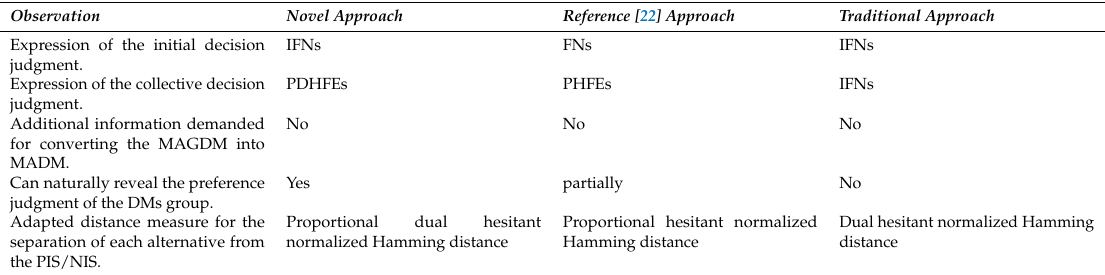
Table 16. Similarities and dissimilarities of the novel approach with other